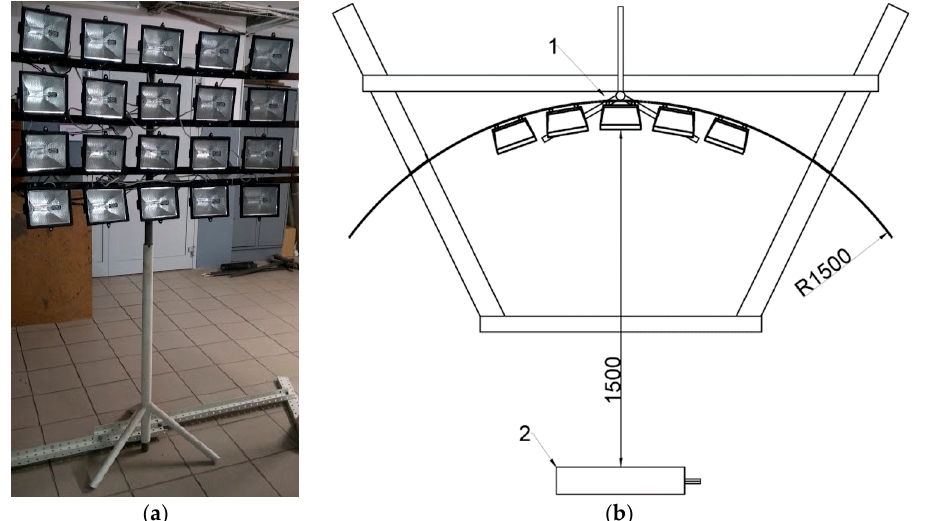
Figure 3. The solar light simulator: ( a ) photography of the solar light simulator; and ( b ) a scheme of the simulator’s location relative to the PV roof tile casing. 1 : The solar light simulator; and 2 : the PV roof tile casing.